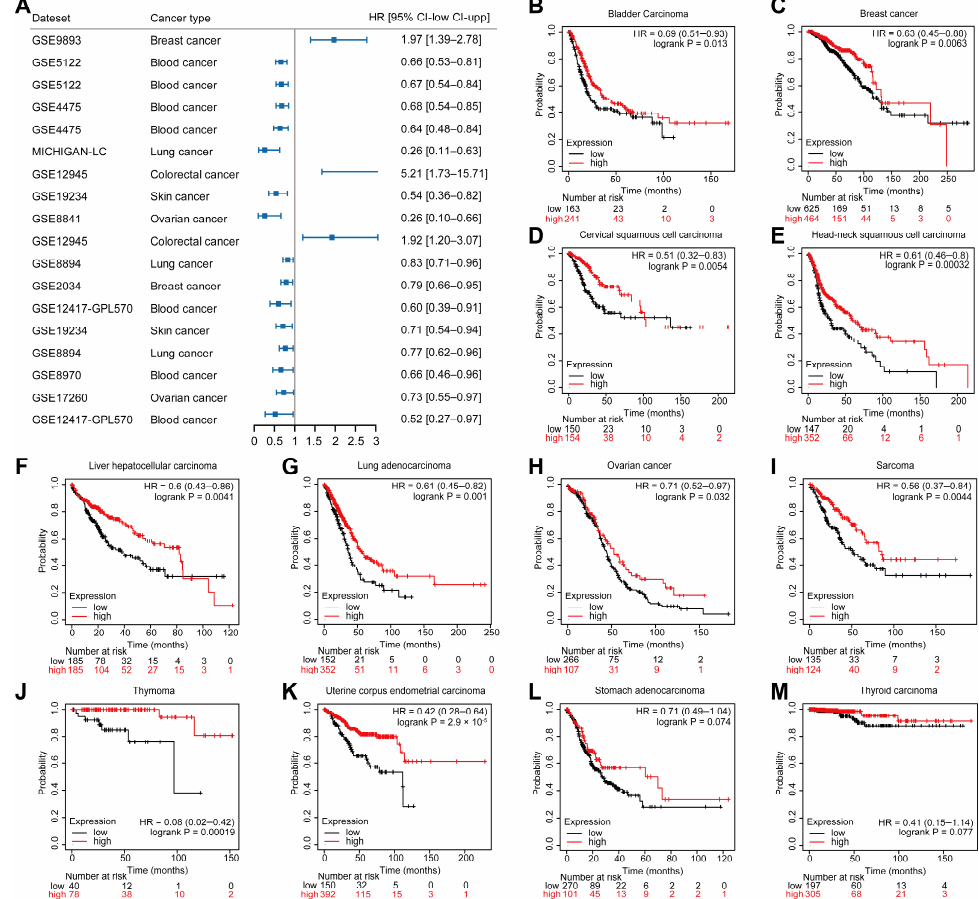
Figure 3. Prognostic value of LCK in different tumors. ( A ) Forest plot of LCK with several data cohorts from PrognoScan database. ( B – M ) Survival curves of LCK in different tumors from Kaplan– Meier Plotter.